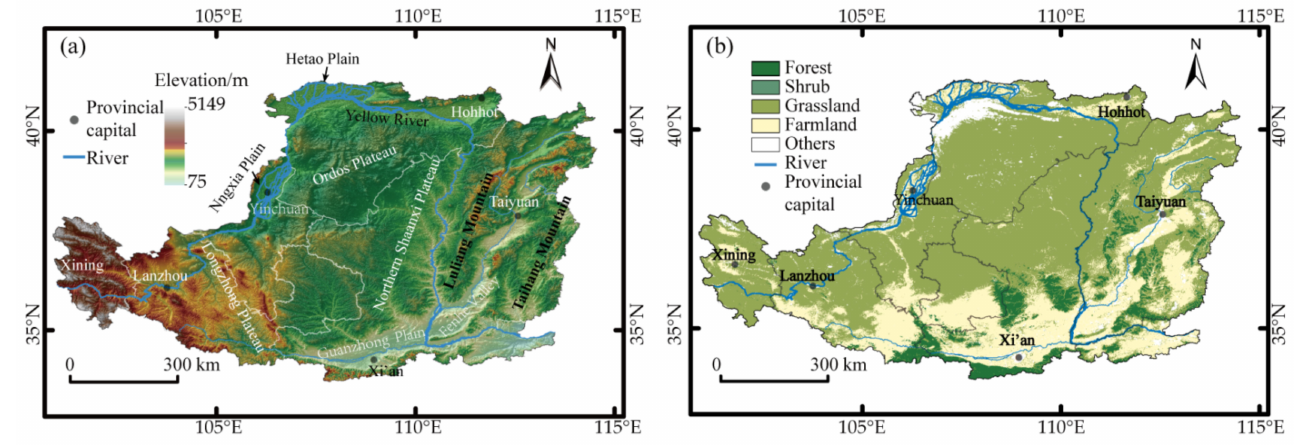
Figure 1. Topographic map ( a ) and vegetation type map ( b ) of the Loess